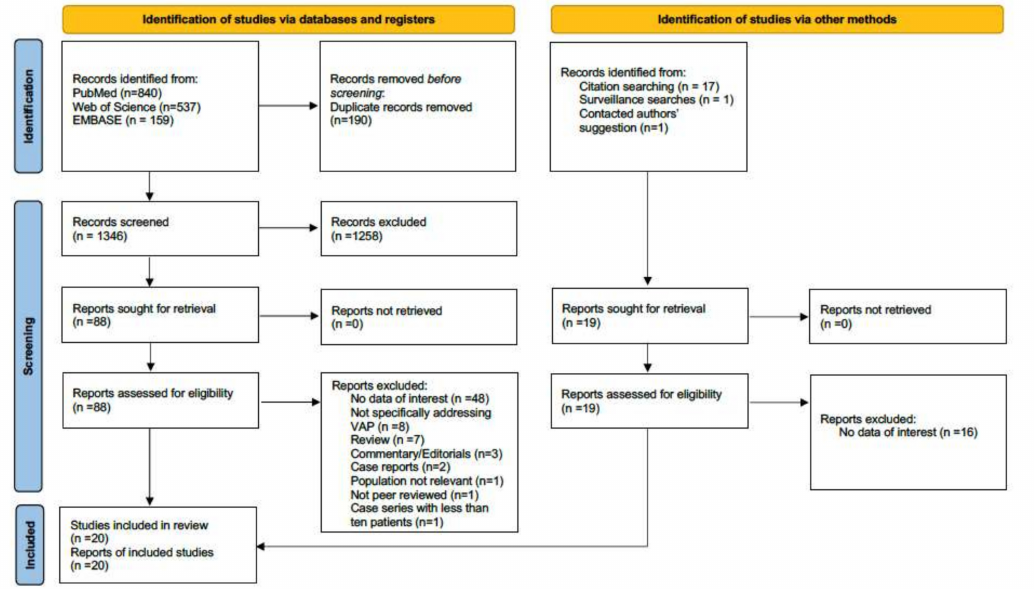
Figure 1. PRISMA 2020 flow diagram for new systematic reviews which included searches of databases, registers and other